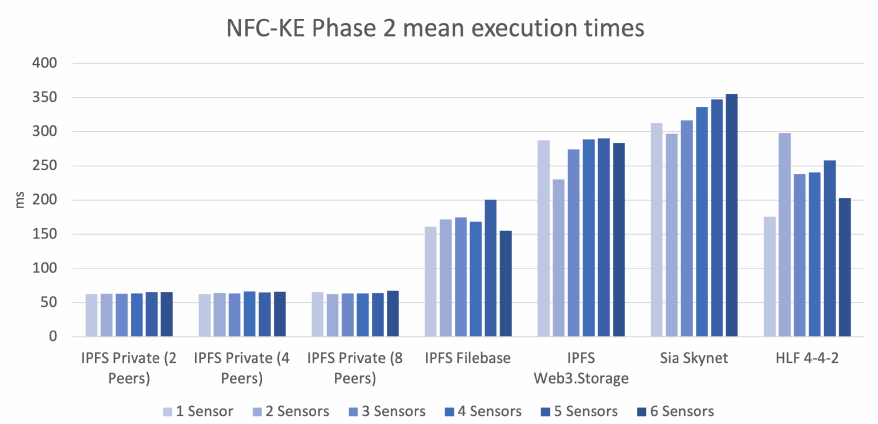
Figure 5. NFC-KE Phase 2 mean execution time